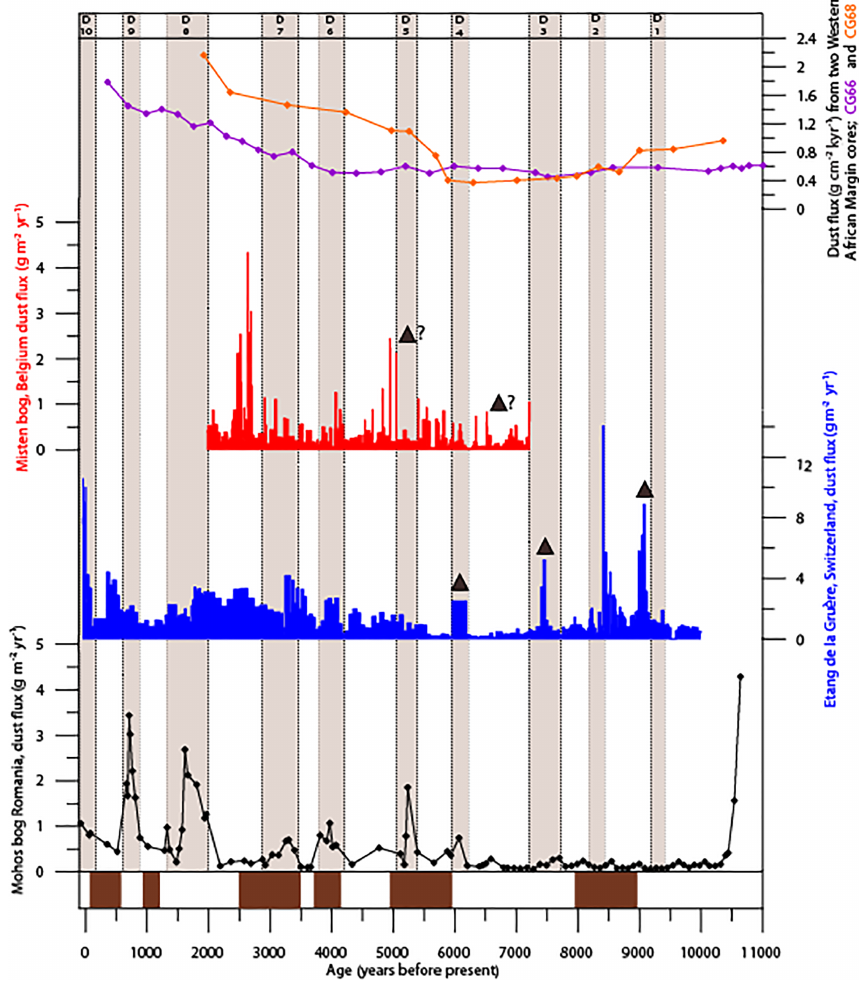
Figure 5. Comparison of dust flux values as reconstructed from the Mohos peat bog with similar records. Two western African dust flux records (GC 68 and 66) from marine cores (McGee et al., 2013) are presented alongside bog-based records from Misten bog in Belgium (Allan et al., 2013) and Etang de la Gruére in Switzerland (Le Roux et al., 2012). Indicated on these records are volcanic events as identified by the authors (brown triangles). These are presented alongside the dust flux record from Mohos (lower panel). Also shown, in brown, are periods of rapid climate change derived from Greenland ice (Mayewski et al., 2004). Vertical bars as in Fig. 3.